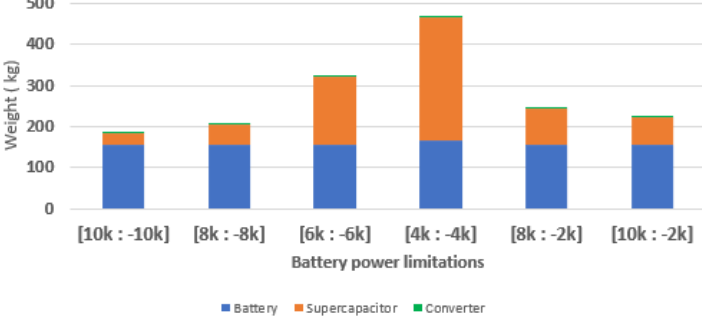
Figure 10. ( a ) Battery power limitation with supercapacitor energy supervision (battery power in blue, supercapacitor power in red). ( b ) Supercapacitor energy.